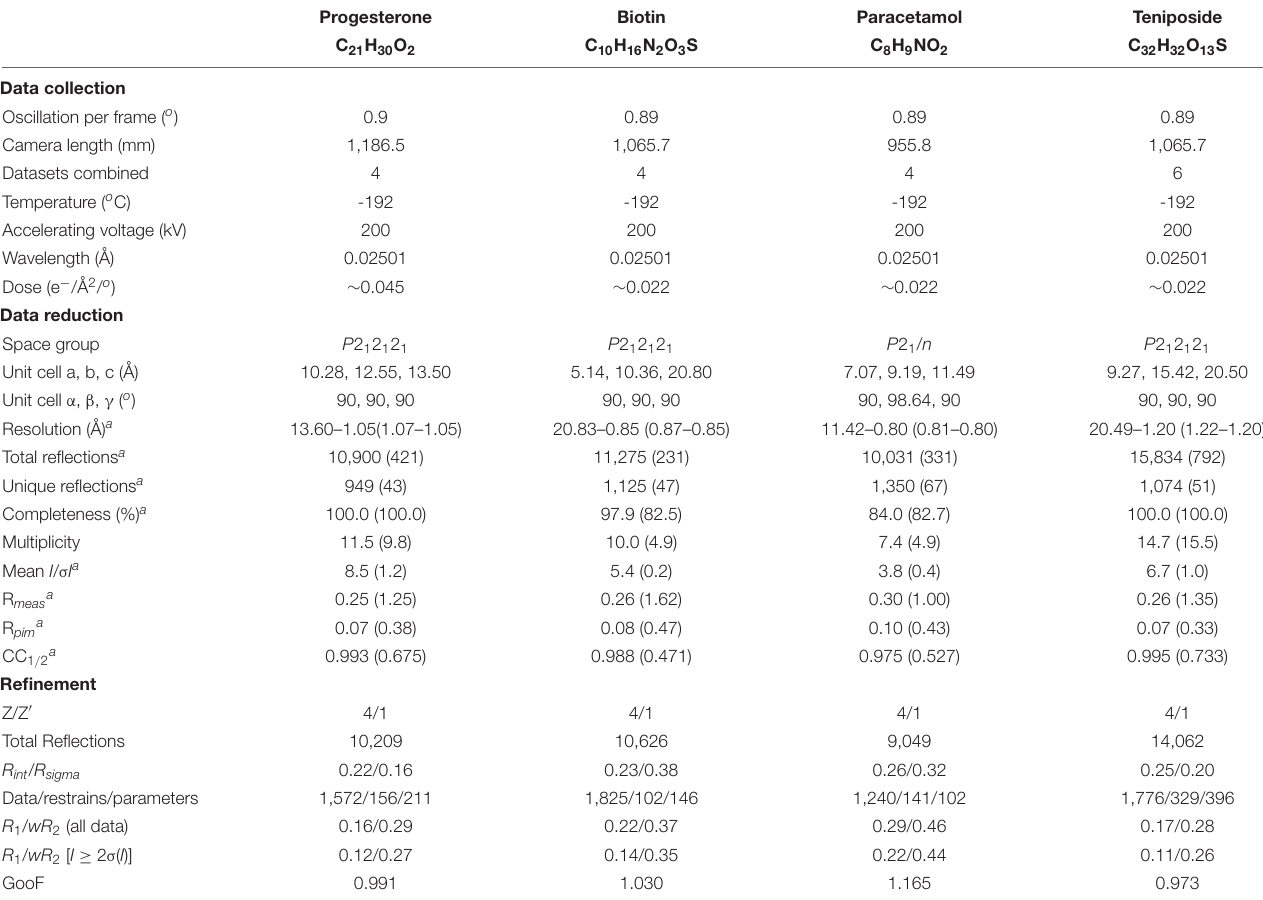
TABLE 1 | Summary of the data collection, reduction, and refinement statistics for four structures determined by